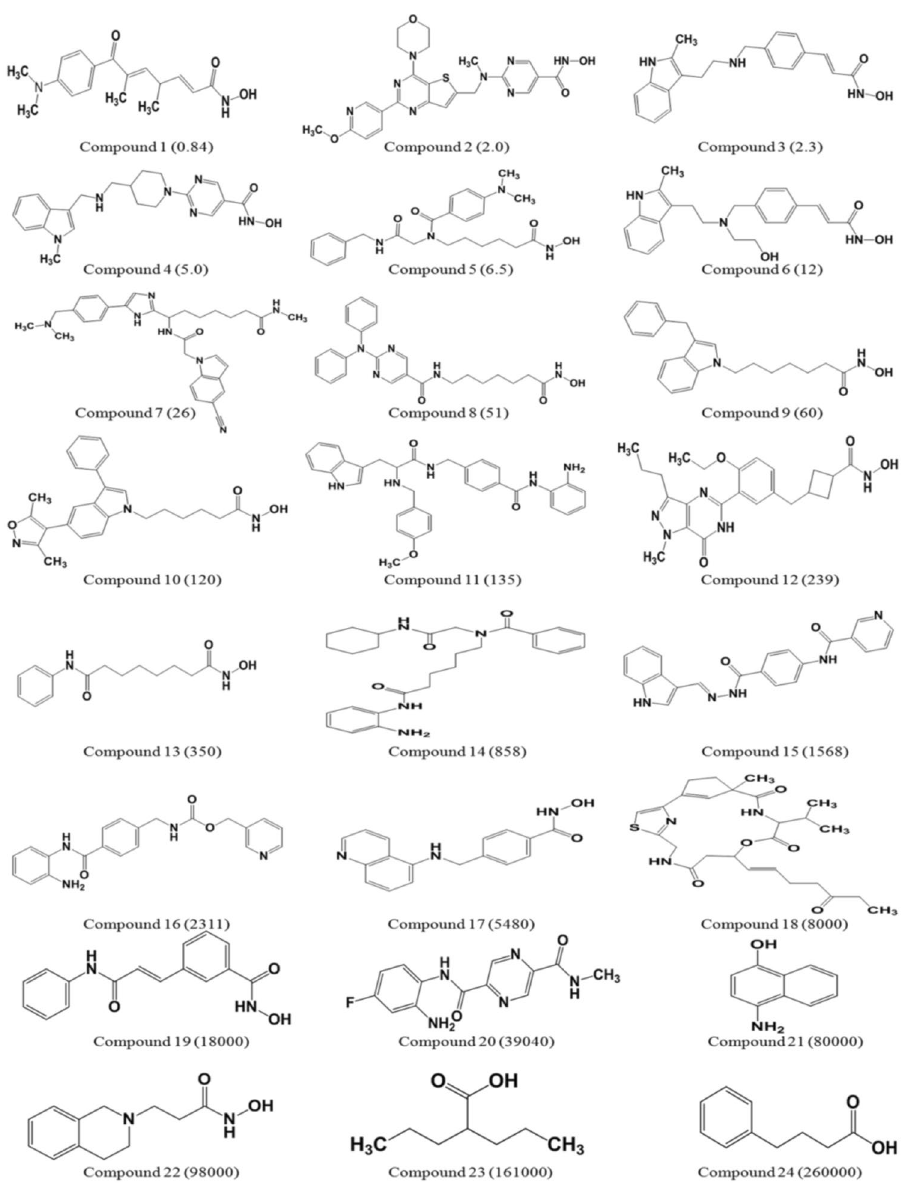
Figure 1. A representation of the 24 chemically diverse training set compounds used for pharmacophore generation. The experimental IC 50 values (nmol/L) are shown in parentheses for each compound. The figure is drawn using ChemDraw Ultra